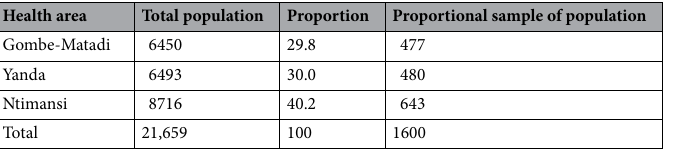
Table 1. Proportional sampling according to health area. Source : Central office of Gombe-Matadi health zone, 2018 18